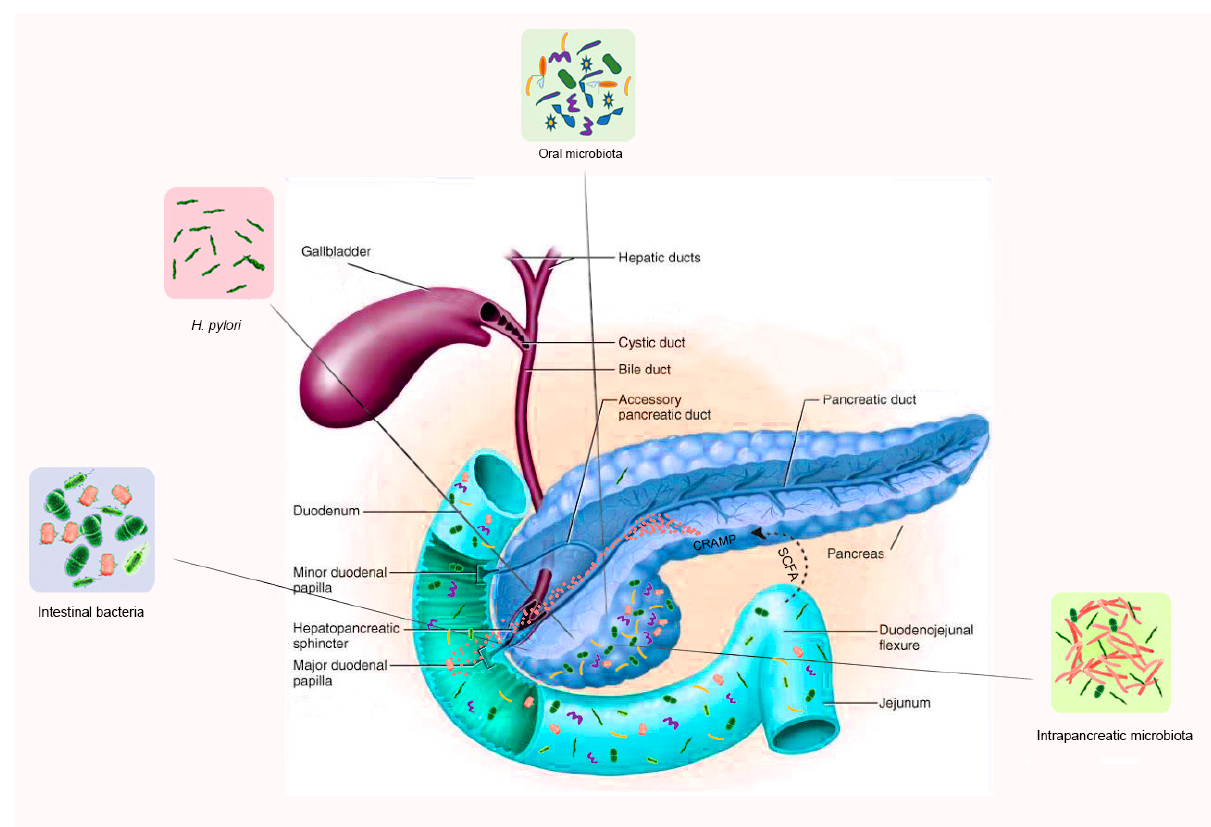
Figure 1. The interplay or cross talk between specific microbiota and pancreatic function, in both health and disease. The short chain fatty acids (SCFA), produced by intestinal bacteria, induce the expression of cathelicidin-related antimicrobial peptides (CRAMP, red dots) in pancreatic β -cells. Impaired CRAMP secretion renders the gut microbiota dysbiotic and results in bacterial overgrowth. The pancreas is colonized under normal physiological conditions by microbes via the pancreatic duct, oral-intestinal route, mesenteric venous drainage, and mesenteric lymphatic drainage.